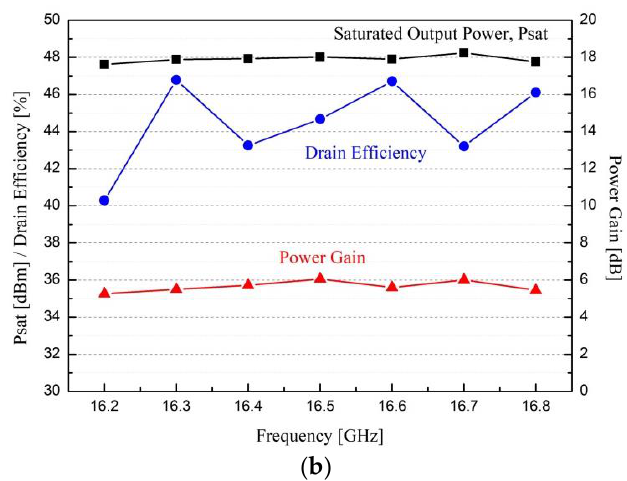
Figure 9. Measured output power performance results of the fabricated power amplifier at V DS = 40 V and I DS = 400 mA under the pulsed condition: ( a ) power gain and drain efficiency with output power at 16.5 GHz and ( b ) saturated output power, power gain and drain efficiency with input signal frequency of 16.2 to 16.8 GHz.